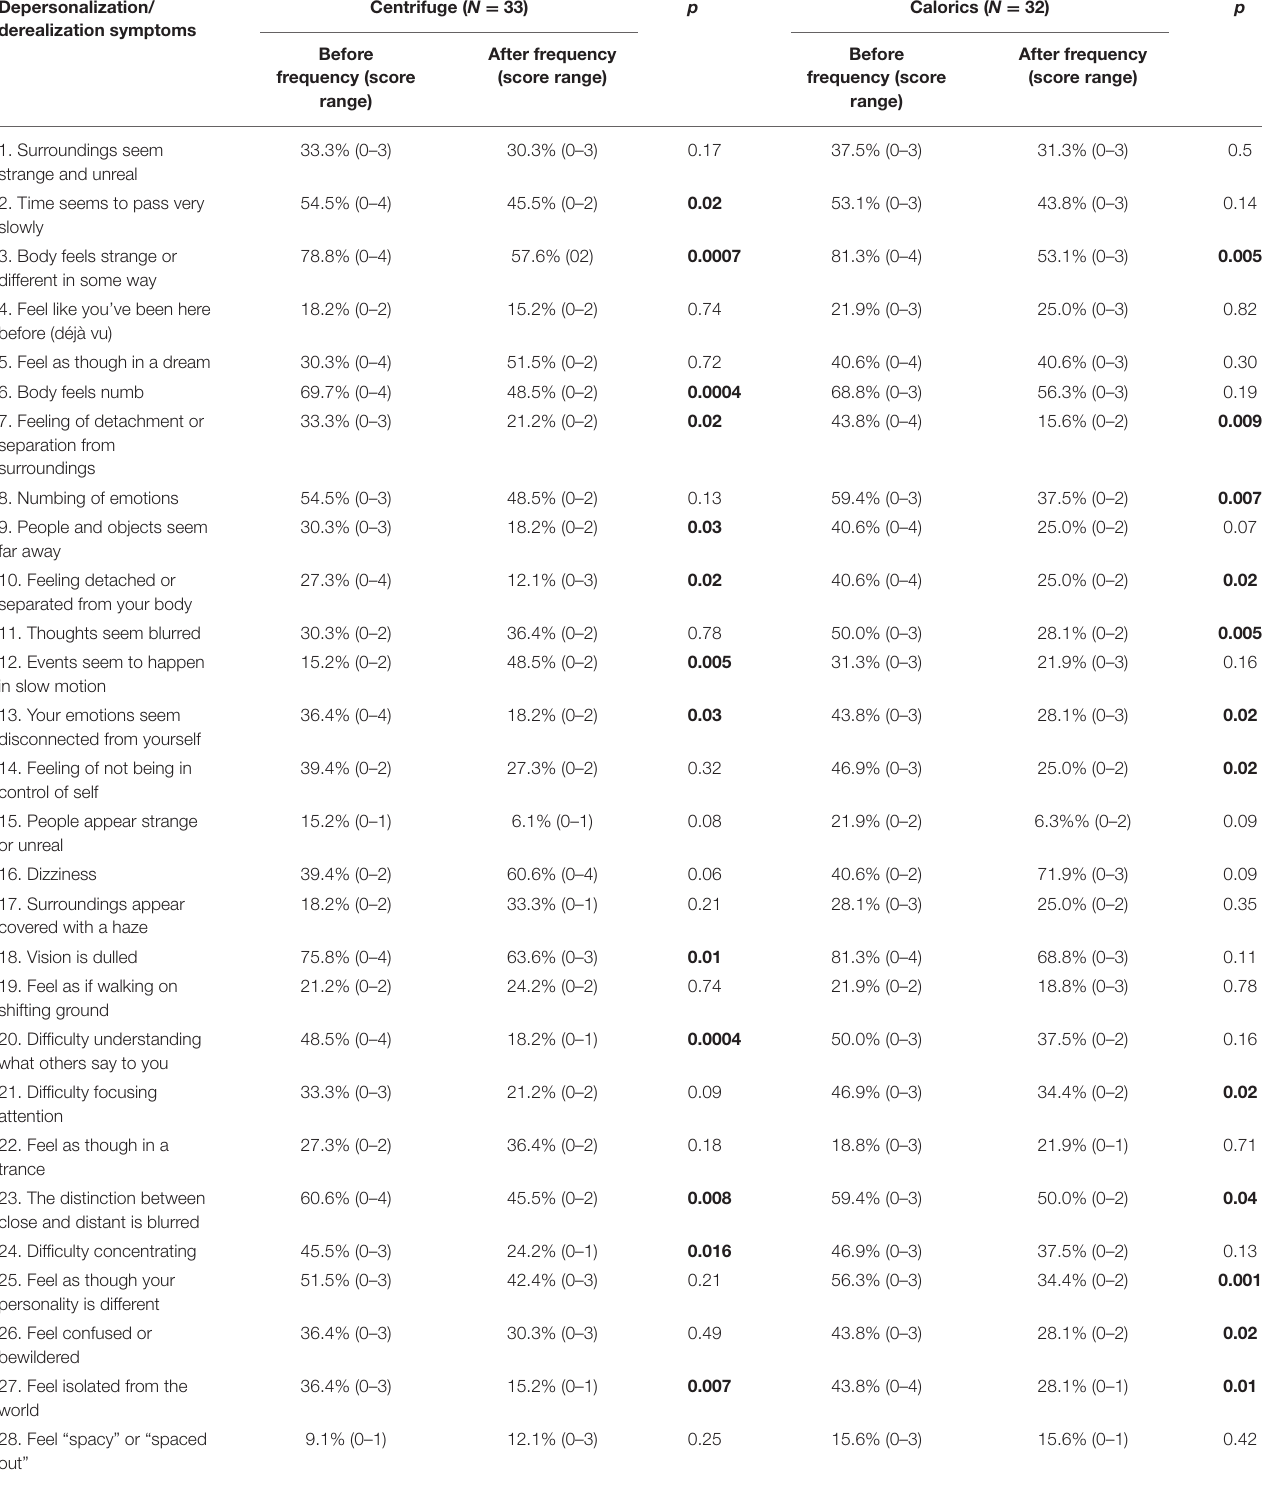
TABLE 3 | Frequency and score range of each of the depersonalization/derealization symptoms (42) reported by the patients before and after vestibular stimulation. Depersonalization/ derealization